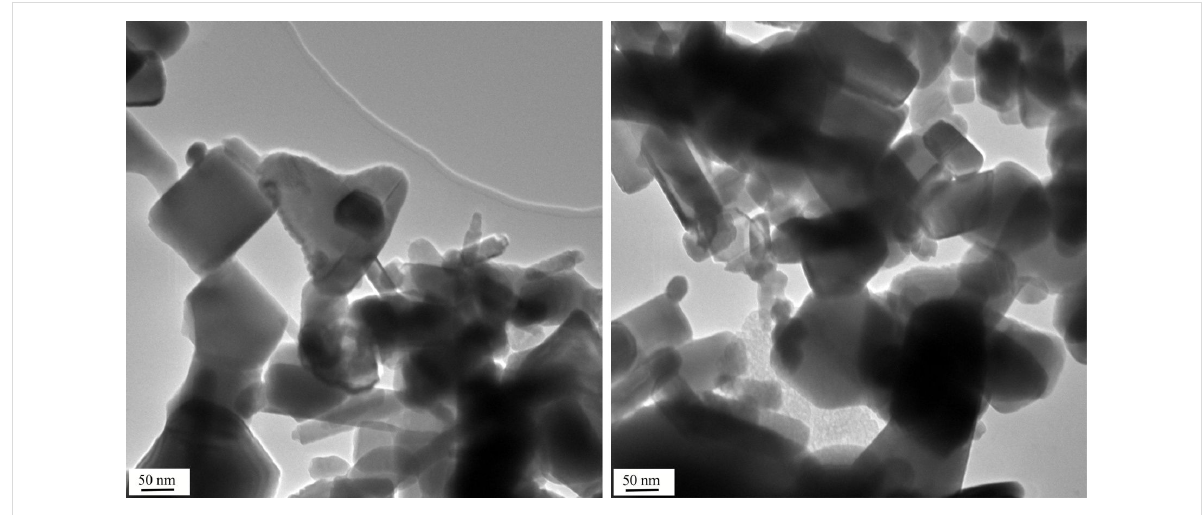
Figure 4: Commercial ZnO sample 3 after treatment with buffer B (2000 mg/L) for one hour. The general appearance is still that of the starting ma- terial, but signs of beginning degradation can be seen at the margin of the central triangular particle (left), and amorphous zinc phosphate starts to appear in the lower part of the right picture. The scale bars are 50 nm.